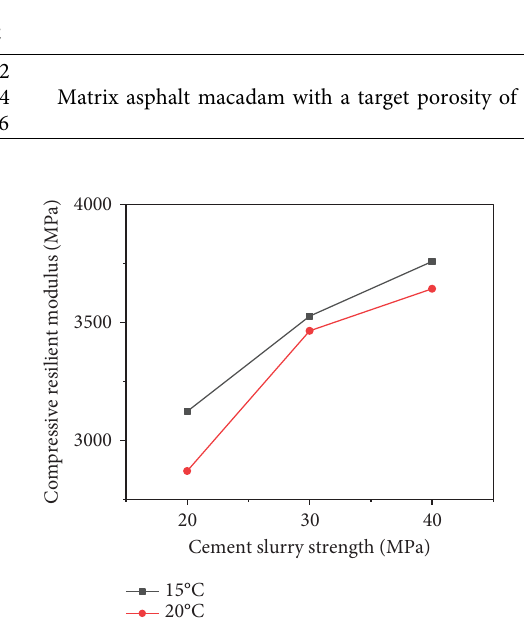
Figure 13: Variation curve of modulus of fexural stifness with cement slurry strength. Table 18: Data processing results of the rebound modulus test at diferent cement slurry strengths. Cement slurry strength (MPa)